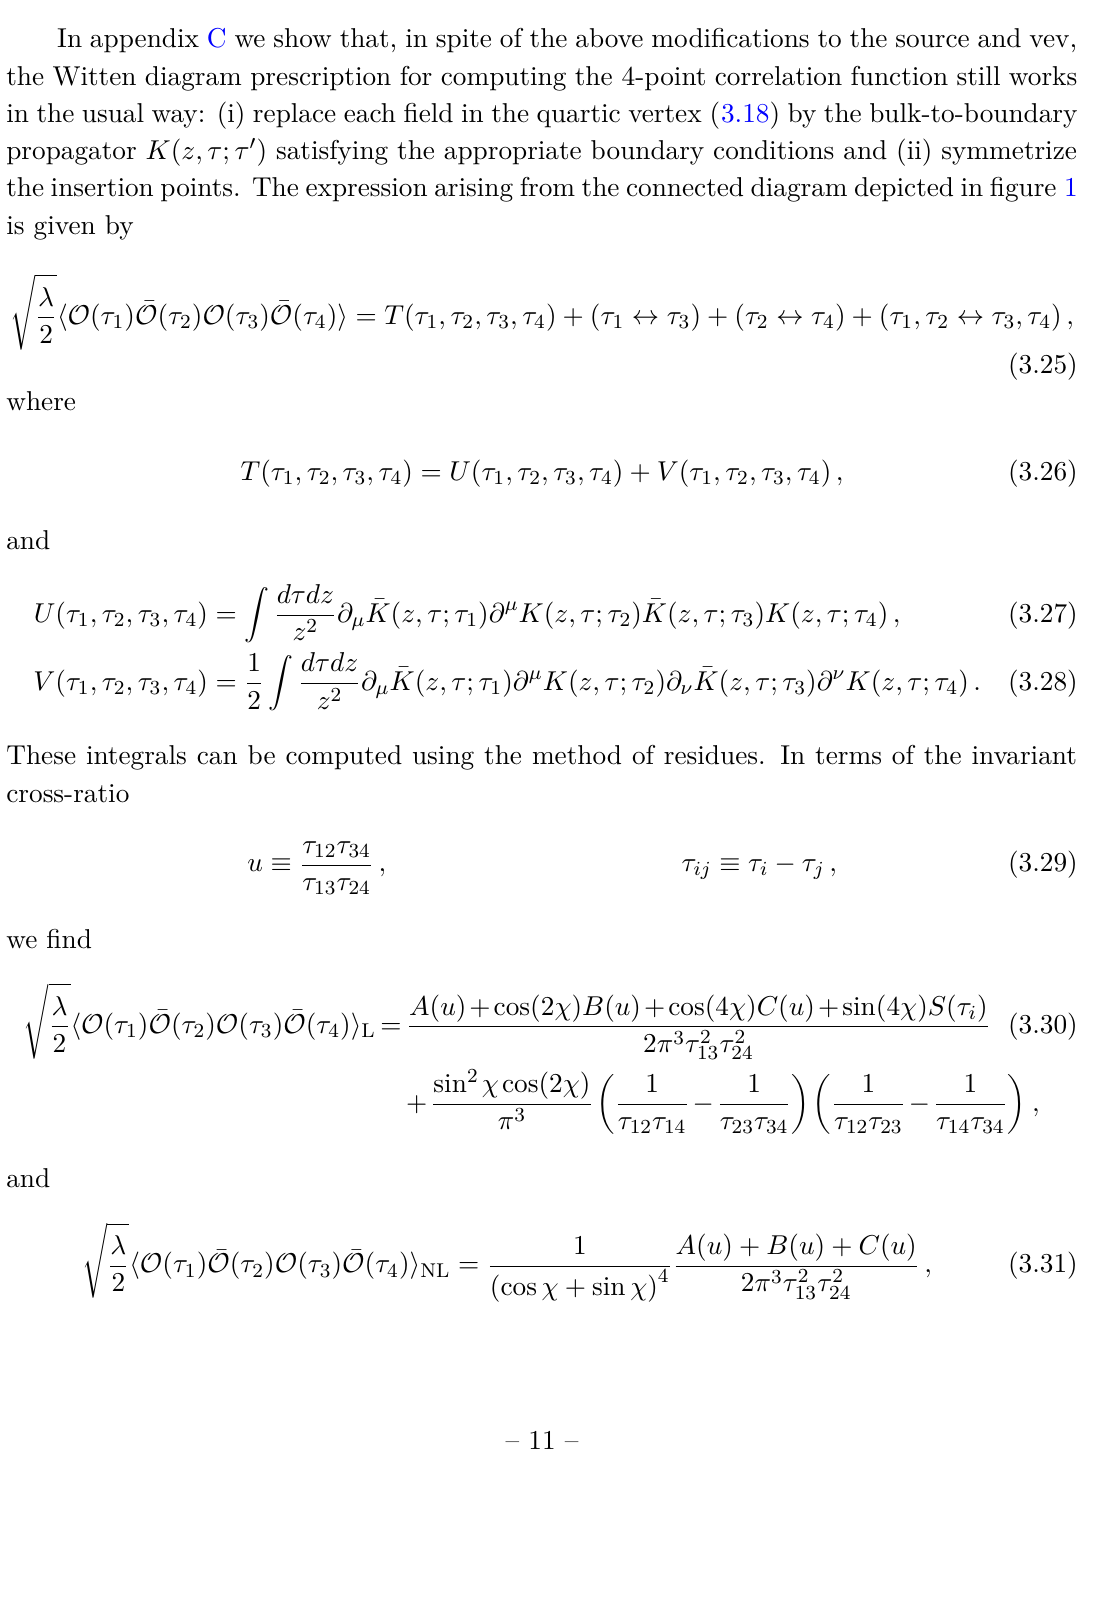
Figure 1 . Tree-level diagram coming from the expansion of the Nambu-Goto